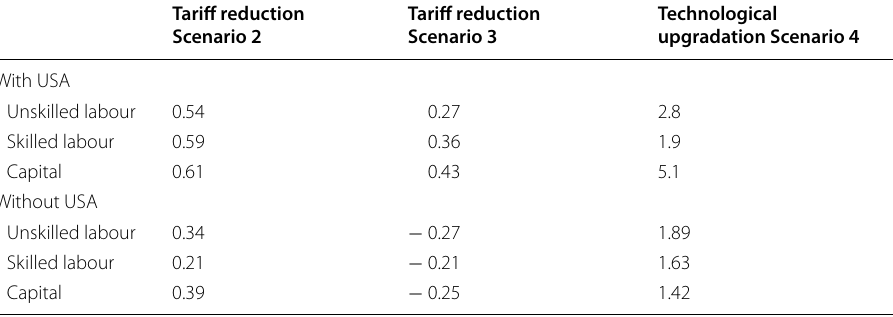
Table 14 Change in factor income for the Canadian economy